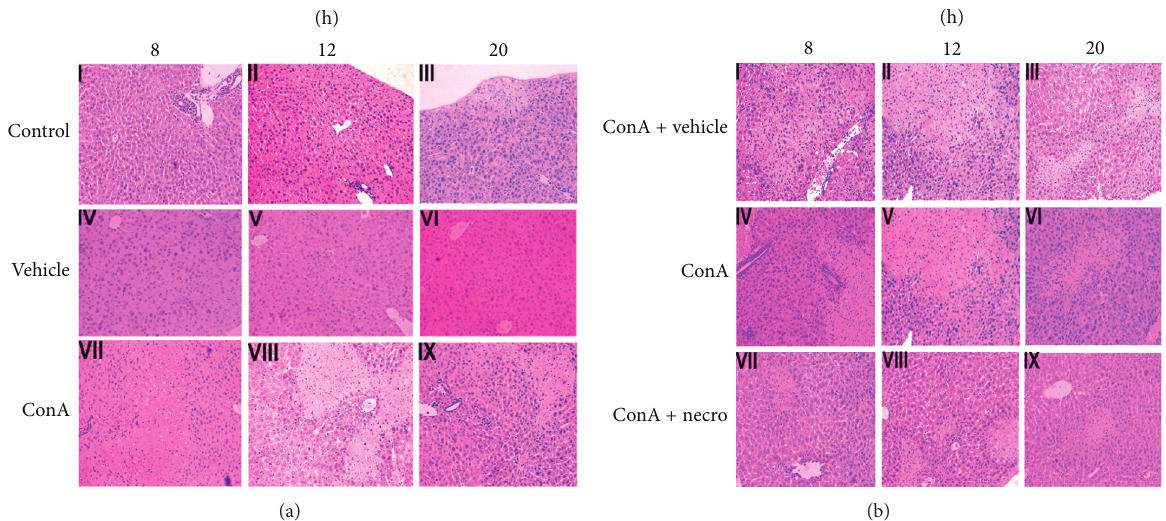
Figure2:(a)Photomicrographsofrepresentativeliverscollected8,12,and20 hafterConAinjection,stainedwithH&E(magnification × 200). The control animals received NSS alone ((a) I–III). The vehicle-injected group received DMSO only, without ConA ((a) IV–VI). The mice in the ConA group were injected in the tail vein with ConA for at 8, 12, or 20 h. H&E, × 200 magnification ((a) VII–IX). These experiments were repeated three times, and the same results are shown. (b) Photomicrographs of representative livers collected at 8, 12, and 20 h after ConA injection, stained with H&E (magnification × 200). The vehicle group was intraperitoneally injected with DMSO 1h before ConA challenge